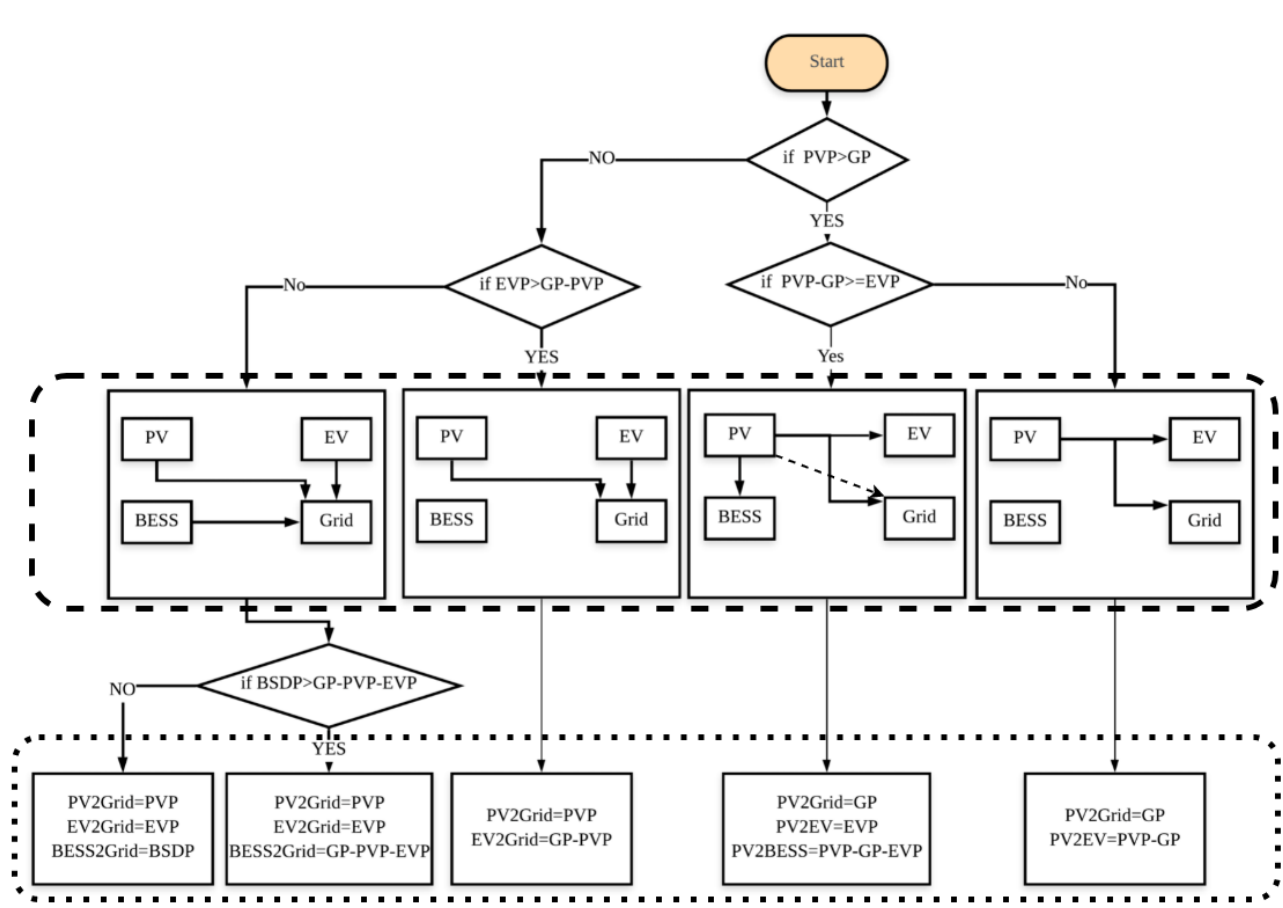
Figure 4. The energy flow in the